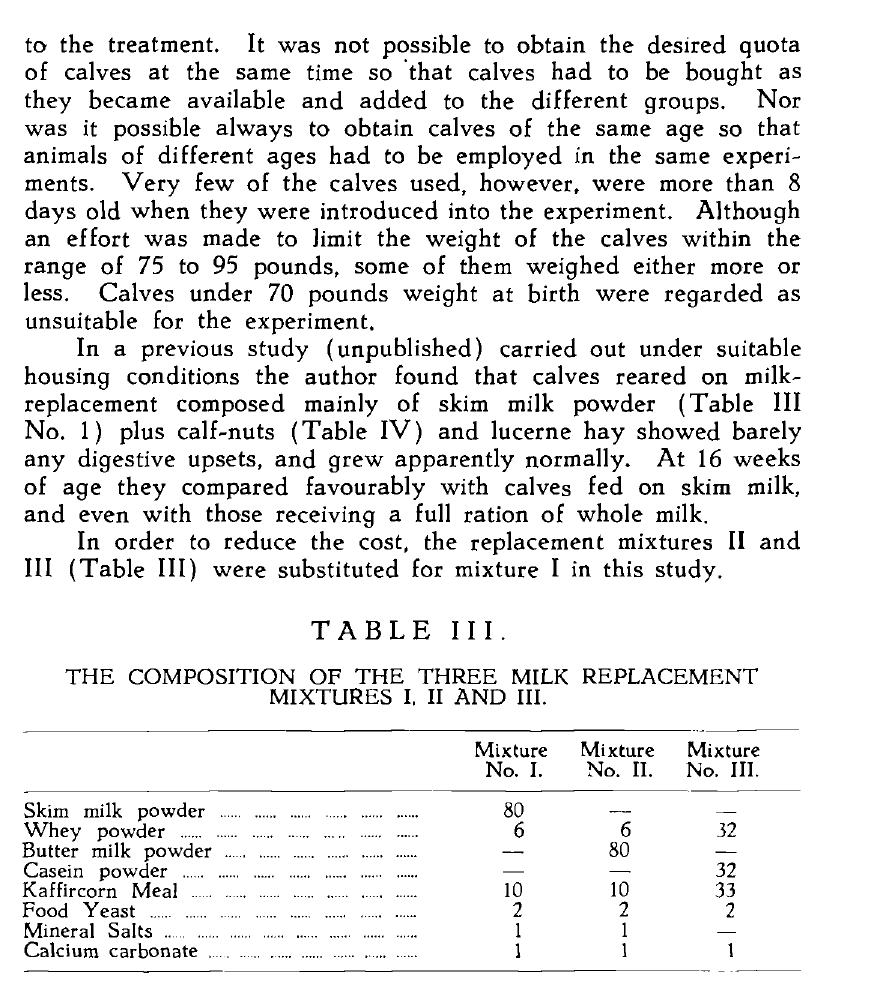
Yellow Mealie meal Kaffircorn meal Wheaten bran Peanut-Cake